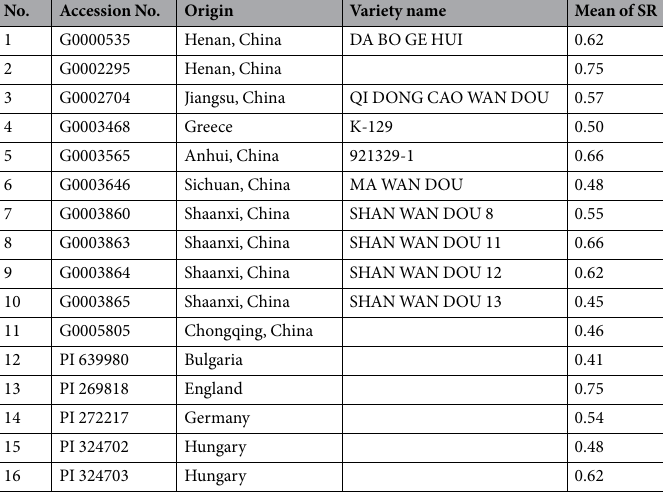
Table 2. Sixteen winter-hardy accessions survived in all nine field experiments for frost tolerance across Binzhou, Yantai and Qingdao, Shandong province, China from 2013 to